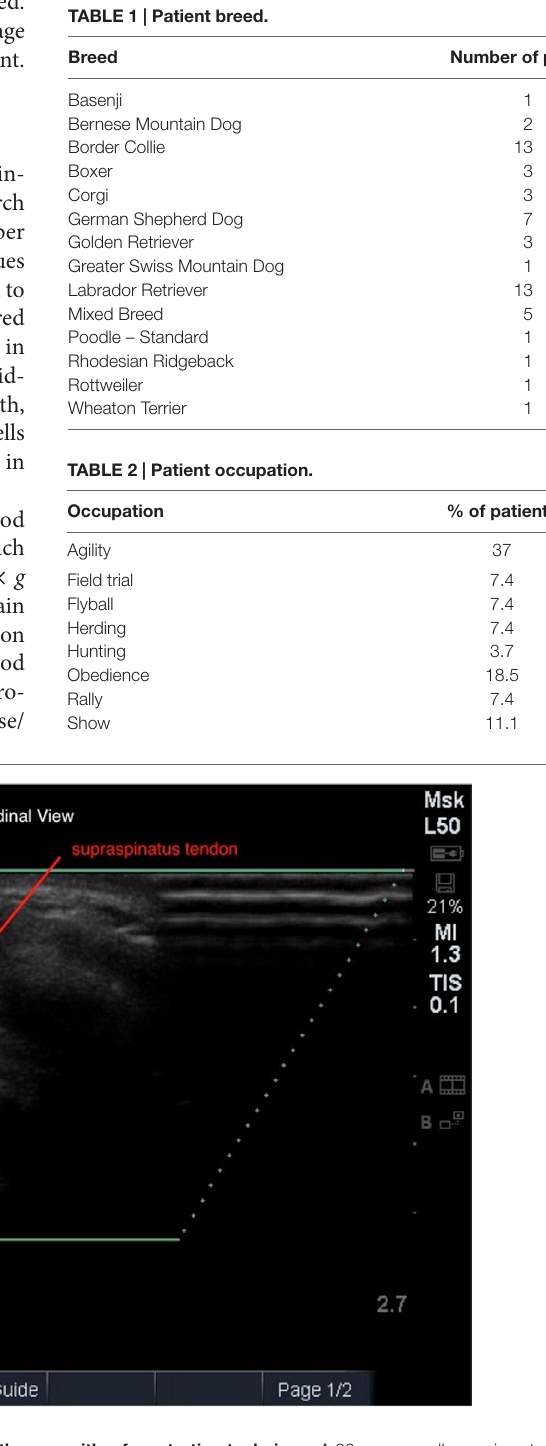
FigUre 3 | Ultrasound guidance was used to administer aDPc-PrP therapy with a fenestration technique . A 22-gage needle was inserted along the long axis of the supraspinatus tendon (red arrow), parallel to the ultrasound transducer. Once the needle was identified in the plane, the needle was advanced into the tendon lesion.